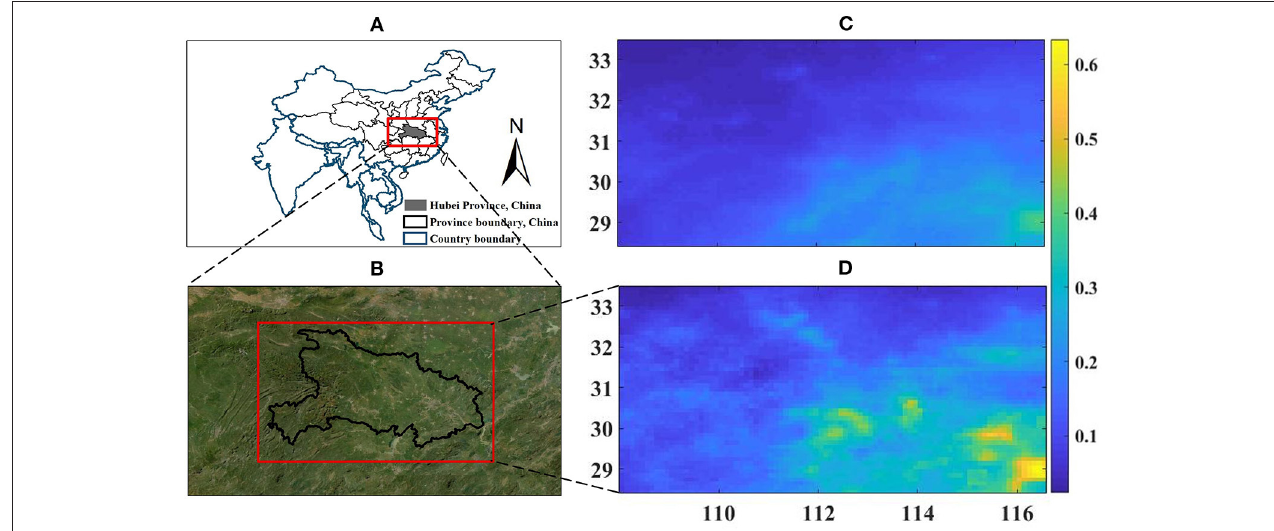
FIGURE 1 | (A) Location of the study area in the Hubei province, China; (B) Boundaries of the study areas overlying the “World Imagery” ArcGIS Online basemap (Sources: Esri, DigitalGlobe, GeoEye, i-cubed, USDA FSA, USGS, AEX, Getmapping, Aerogrid, IGN, IGP, swisstopo, and the GIS User Community); (C) Average IMERG precipitation in mm/hour during January-April of 2001–2019; and (D) Average IMERG precipitation in mm/hour during January-April 2020.